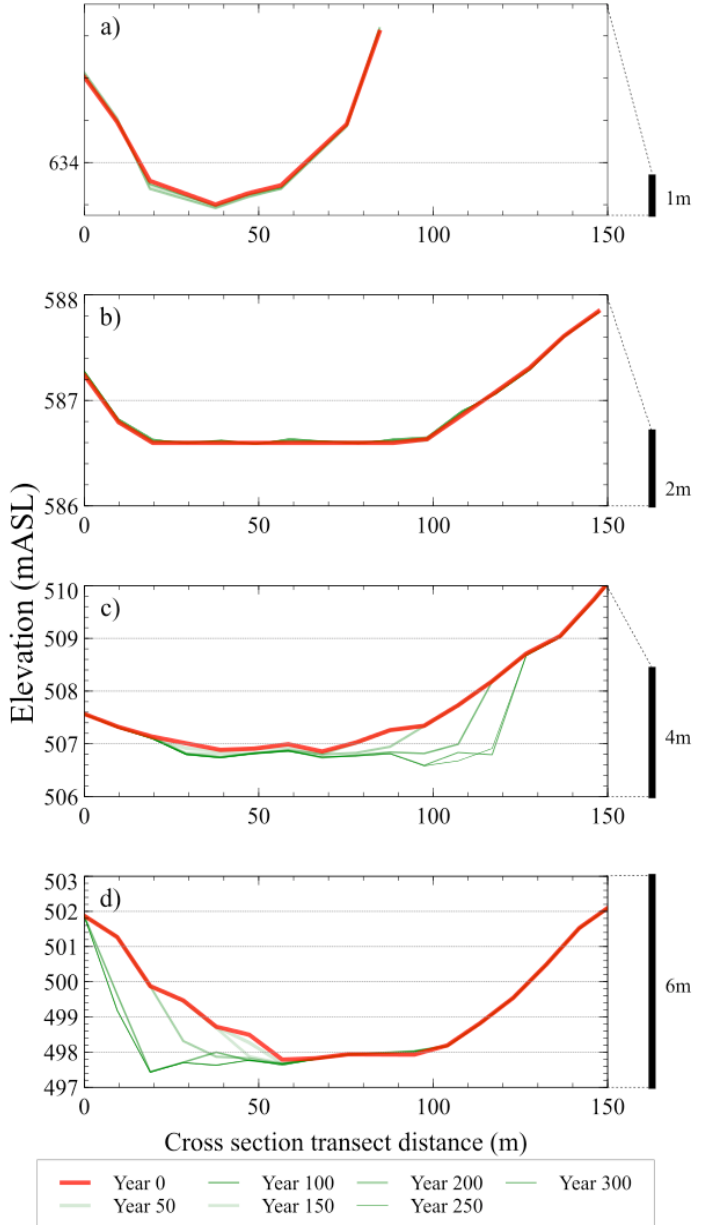
Figure 7. ( a – d ) Four cross-sections of the main Barranco : two profiles upstream from Mas d’Is, near Mas d’Is, and downstream from Mas d’Is. The red line shows the starting reconstructed mid-Holocene cross-section, and the green lines show the cross-section at 50-year intervals during one run of the maximizing large-population experiment. Incison and lateral erosion are apparent at all cross sections, although the absolute amount of incision is greater in the downstream cross sections. The locations of the cross-sections are shown in Figures 5 and